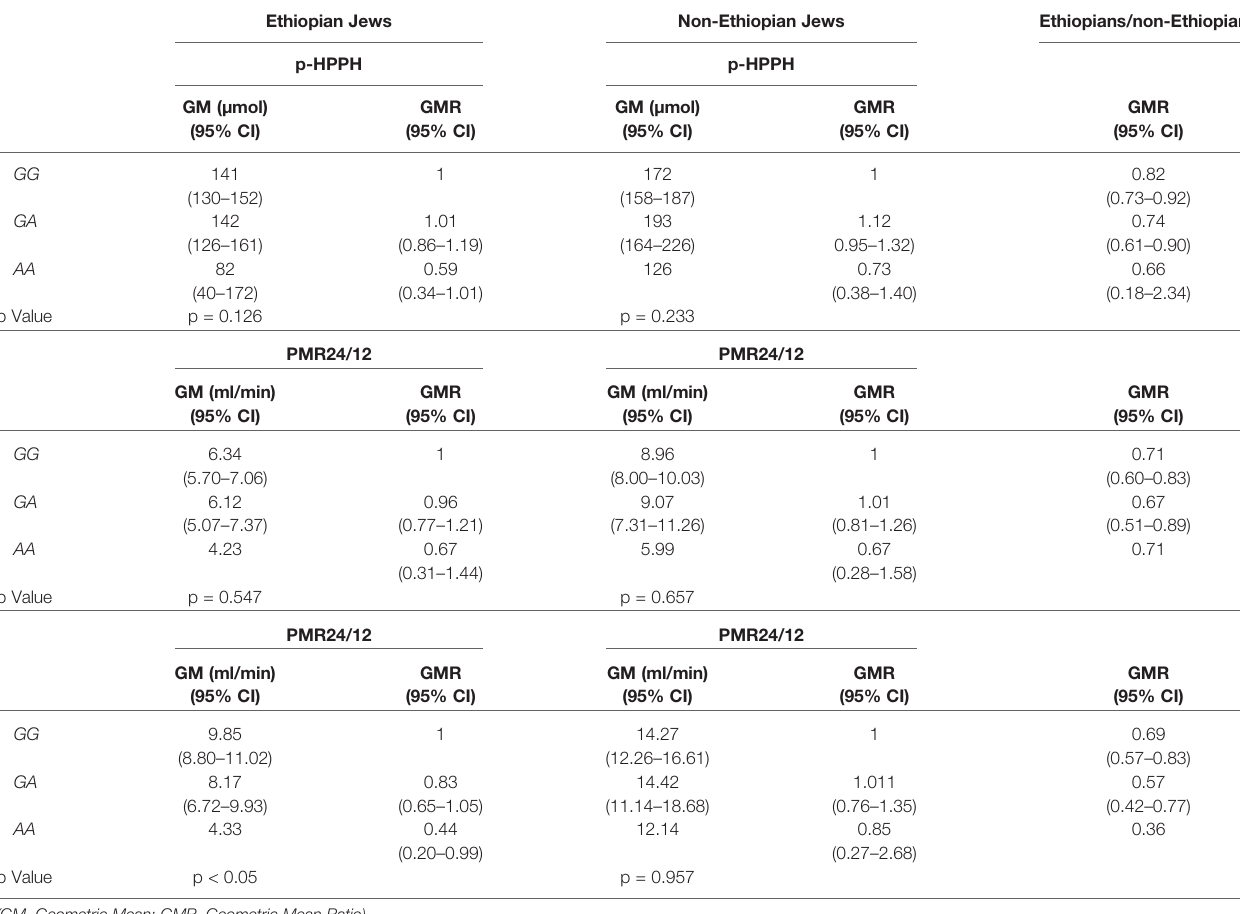
TABLE 6 | Urinary excretion of p-HPPH over 24 h, PMR24/12 and PMR24/24 according to rs12777823 genotype among non-carriers of CYP2C9*2 , *3 , *5 , *6 , *8 , and *11 in the Ethiopian and non-Ethiopian groups.